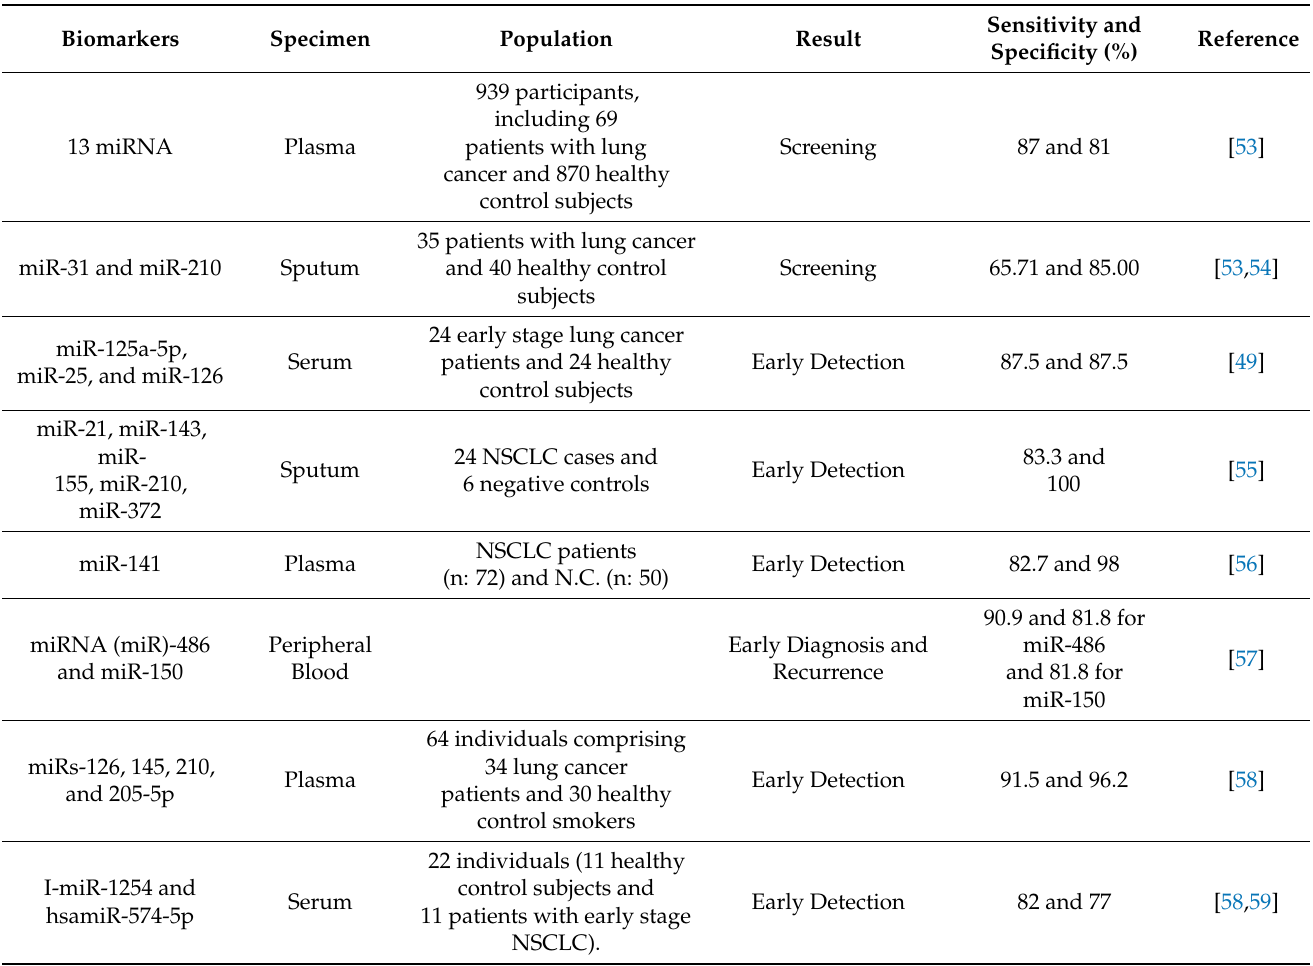
Table 2. MicroRNA biomarkers for early detection of